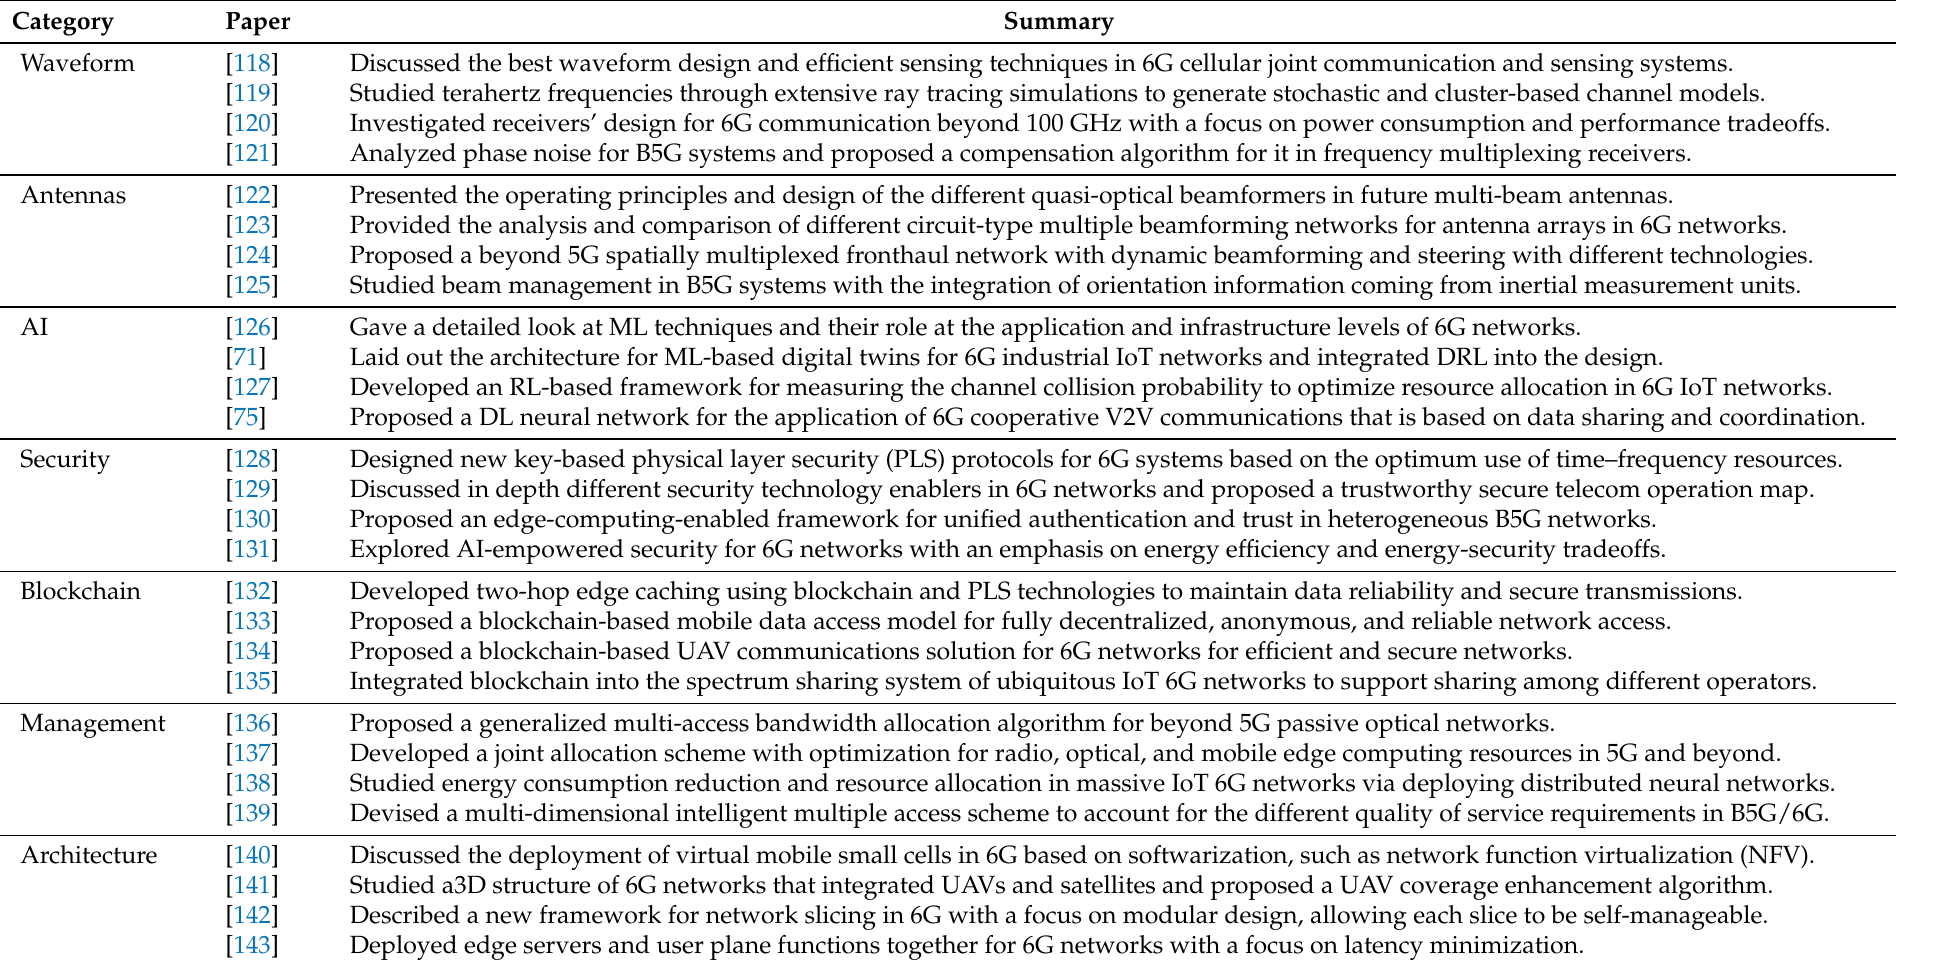
Table 3. Summary of surveys on some of the B5G/6G